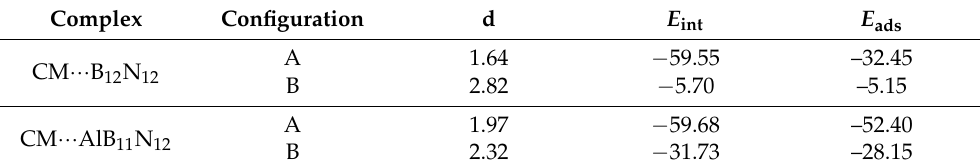
Figure 3. Optimized structures of CM ∙∙∙ B 12 N 12 and ∙∙∙ AlB 11 N 12 optimized complexes within configu- rations A and B (at M06-2X/6-311+G** level of theory) along with molecular electrostatic potential (MEP) maps. MEP maps are plotted using electron density envelopes of 0.002 au. The color scale varies from − 0.01 (red) to +0.01 (blue) au. Intermolecular distances (d) within the optimized com- plexes are given in Å. Table 1. Interaction energy ( E int , kcal/mol) of CM ∙∙∙ B 12 N 12 and ∙∙∙ AlB 11 N 12 optimized complexes and adsorption energy ( E ads , kcal/mol) within configurations A and B. Intermolecular distances (d) are given in Å.